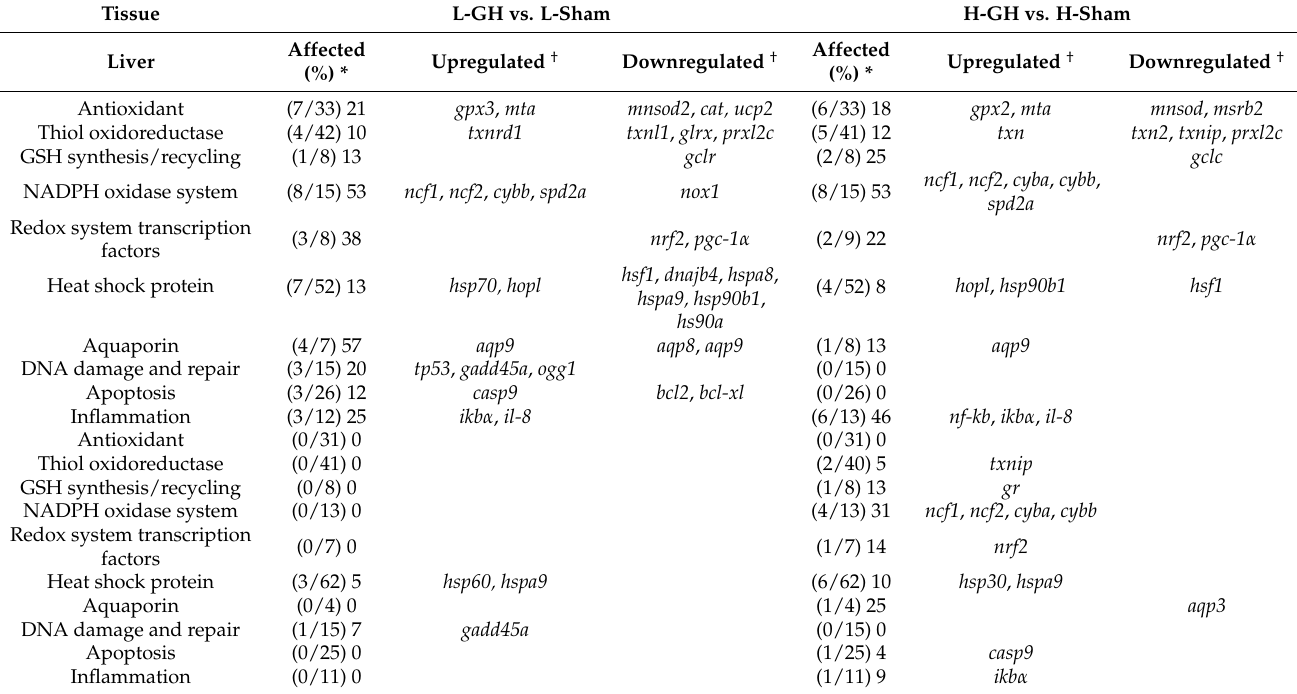
Table 3. A summary of the changes in differentially expressed genes (DEGs) involved in redox system regulation in response to GH and dietary vitamin C and E in liver and muscle of Atlantic salmon. Tissue L-GH vs. L-Sham H-GH vs.